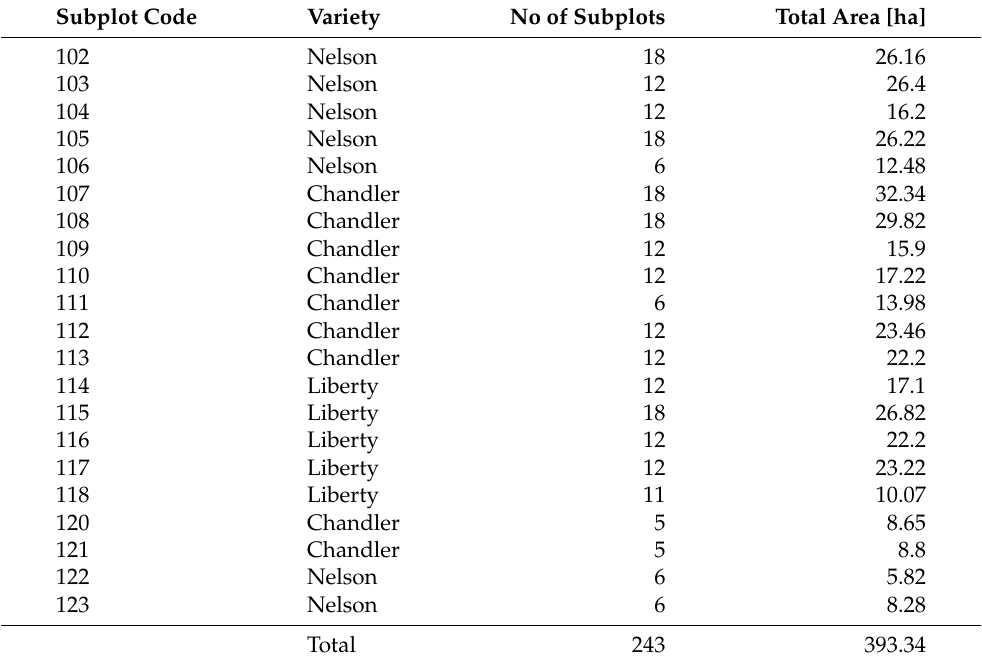
Table 1. Structure of Highbush blueberry